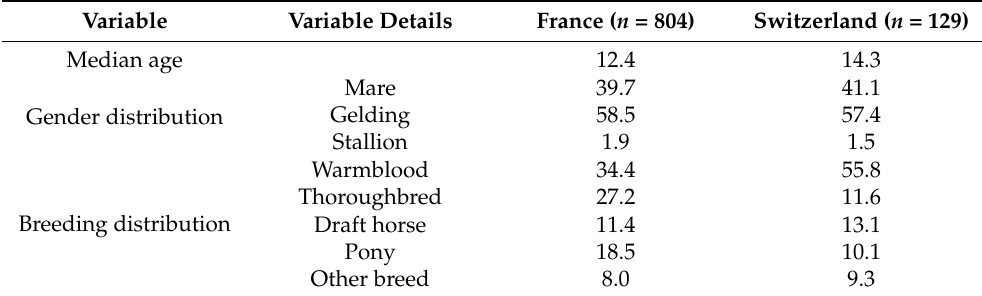
Table 1. Median age, gender, and breeding distribution of all participating horses for each country are given in